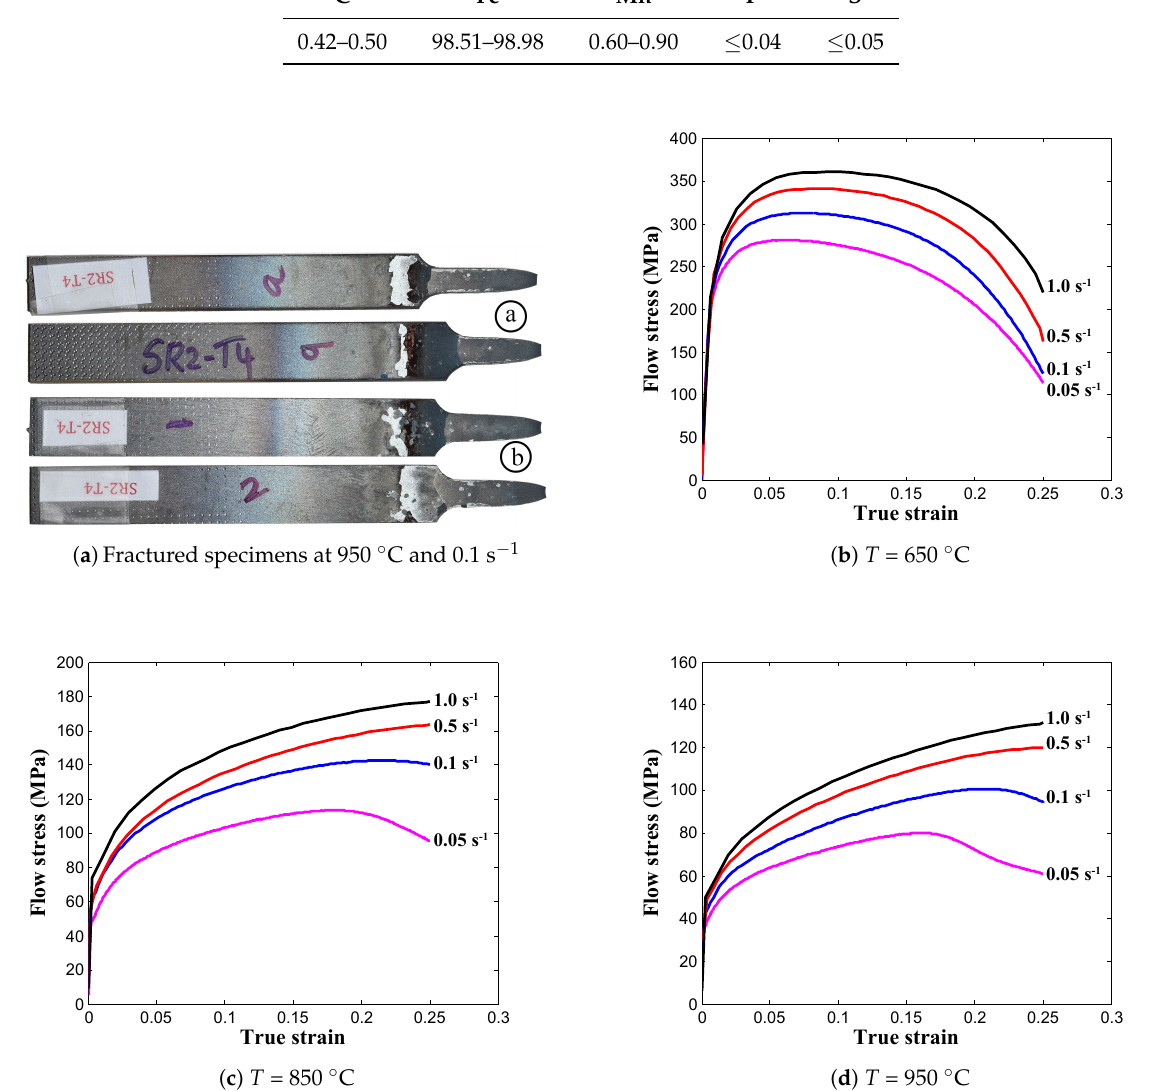
Figure 2. True strain-true stress data obtained from hot tensile tests at various temperatures under different strain